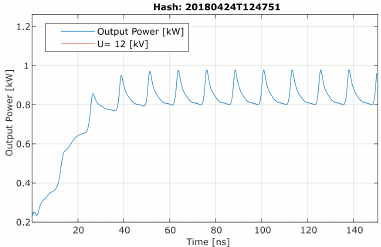
Figure 5. Gyrotron output power in the time